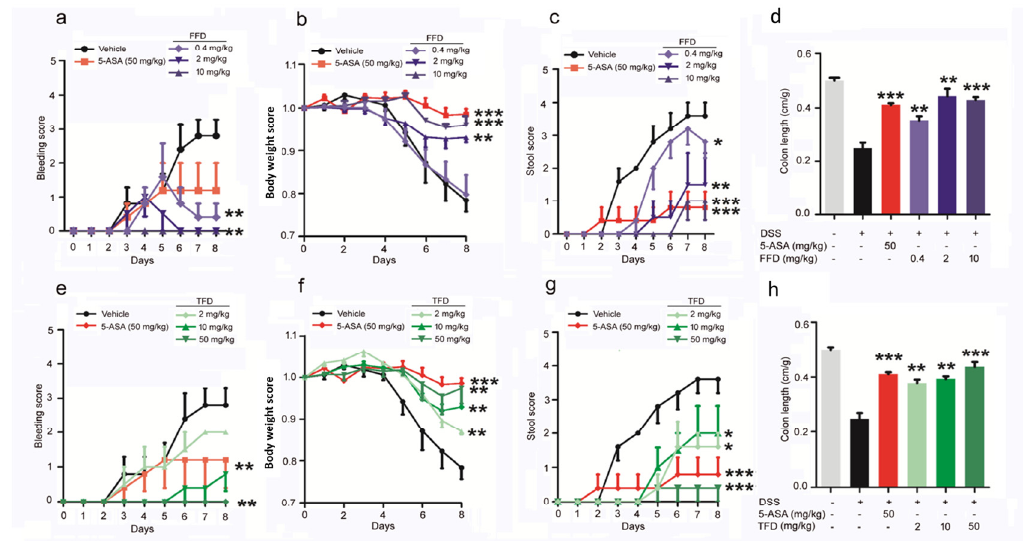
Figure 1. Clinical scores of Fexofenadine (FFD)-treated or Terfenadine (TFD)-treated, or controls in DSS model mice. DSS-induced colitis model was established in 8-week-old C57BL/6 mice with ad libitum access to drinking water containing 3% DSS for 10 days, followed by normal drinking water for 3 days. 5-ASA (serving as a positive control, 50 mg/kg), Fexofenadine (FFD, 0.4, 2, 10 mg/kg), and Terfenadine (TFD, 2, 10, 50 mg/kg) were orally delivered beginning 3 days before delivery of DSS in drinking water and continuing until the mice were sacrificed. ( a – d ) Clinical score of controls and FFD-treated groups. ( a ) Bleeding scores of controls and FFD-treated groups. ( b ) Body weights of controls and FFD-treated groups. ( c ) Stool score of controls and FFD-treated groups. ( d ) Colon lengths of controls and FFD-treated groups. ( e – h ) Clinic score of controls and TFD-treated groups. ( e ) Bleeding scores of controls and TFD-treated groups. ( f ) Body weights of controls and TFD-treated groups. ( g ) Stool score of controls and TFD-treated groups. ( h ) Colon lengths of controls and TFD-treated groups. n = 6 per group. Statistical analysis was done to compare the treatment groups and vehicle groups. Data are mean ± SE; * p < 0.05, ** p < 0.01, *** p <